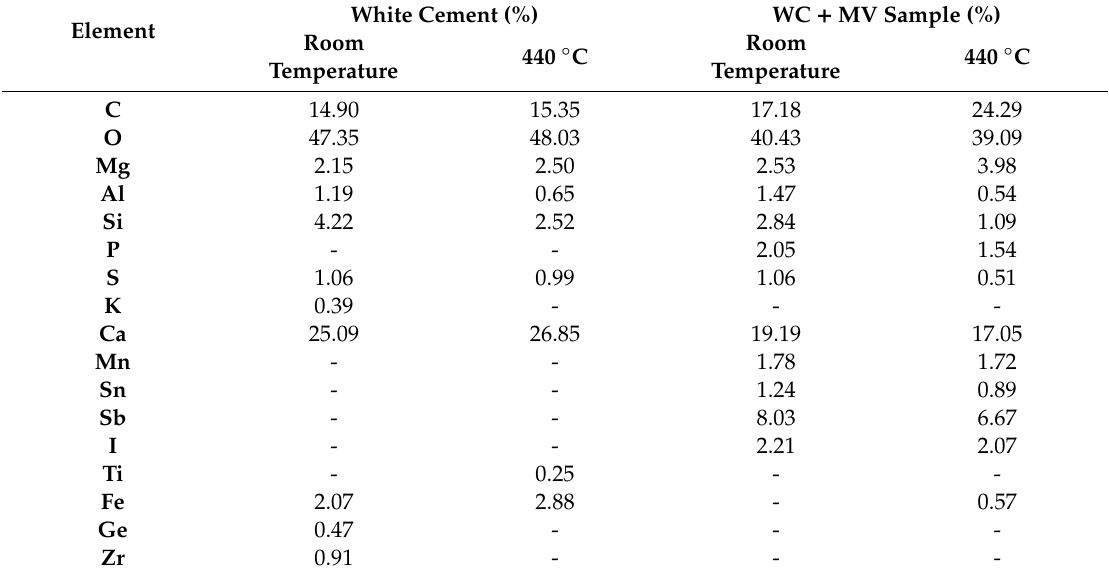
Table 2. EDX analysis of the white cement mixed samples—weight